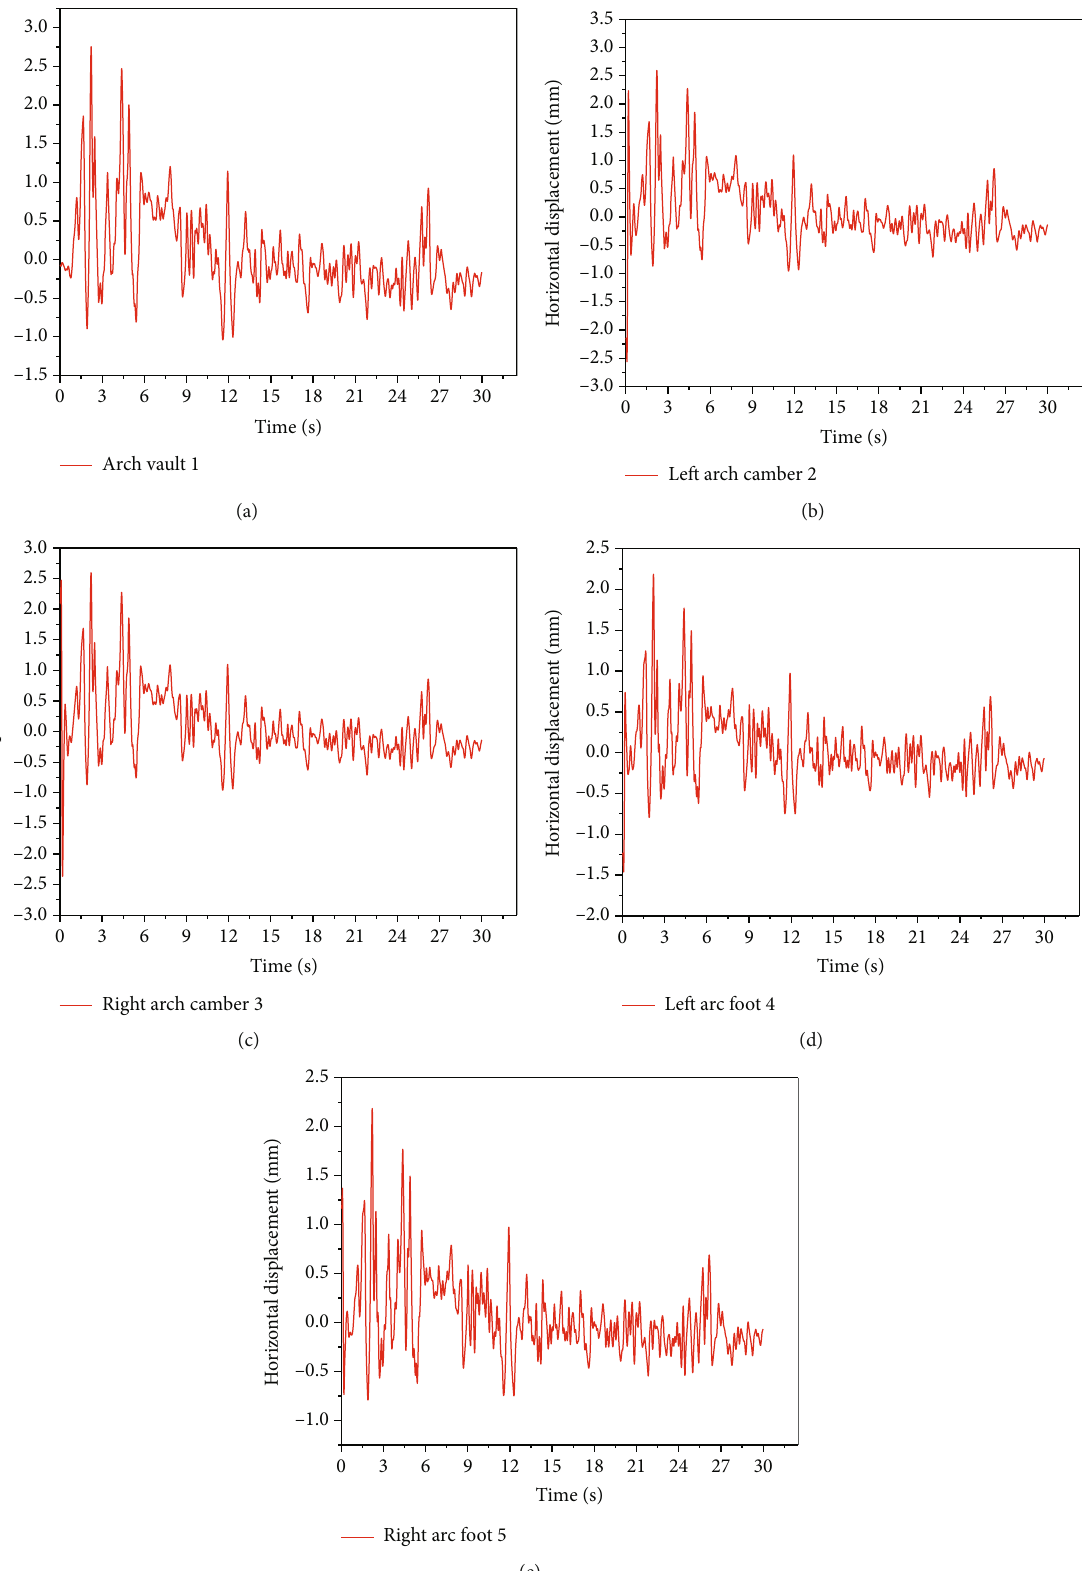
Figure 7: Horizontal displacement time-history diagram of the fi ve key points under 0.05g seismic